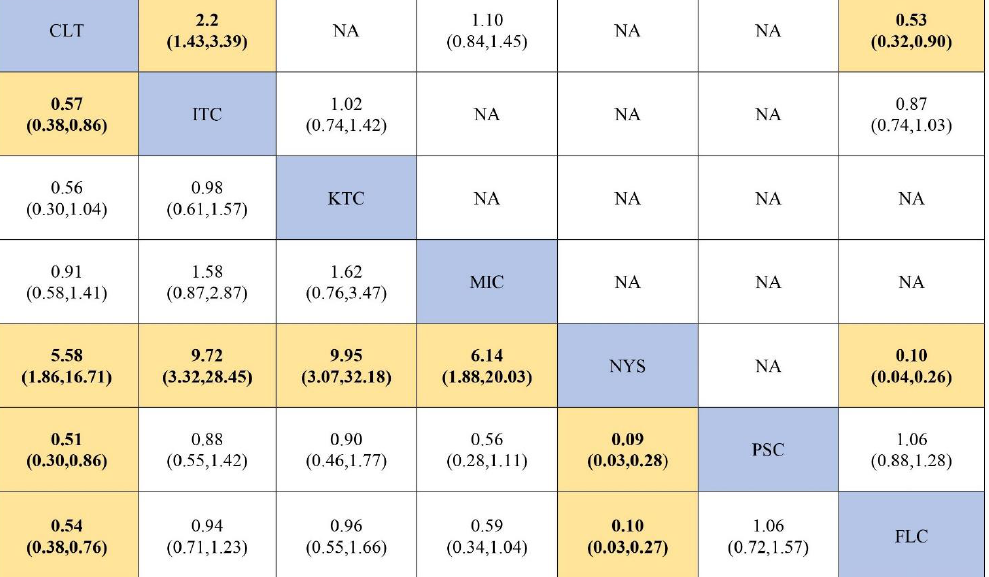
Figure 8. Comparative efficacy of different antifungal agents in the treatment of OPC (mycological cure). Note: pairwise (upper right portion) and network (lower left portion) meta-analytic results. Outcomes are expressed as risk ratio (95% confidence intervals). For the pairwise meta-analyses, a relative risk of more than 1 indicates that the treatment specified in the row is more efficient. For the network meta-analysis, a relative risk of more than 1 shows that the treatment specified in the column is more efficient. Bold and peach shaded results indicate statistical significance. NA — there is no direct comparison to show the effect size. Abbreviations: CLT — clotrimazole, FLC — fluconazole, ITC — itraconazole, KTC — ketoconazole, MIC — miconazole, NYS — nystatin, PSC — posaconazole.